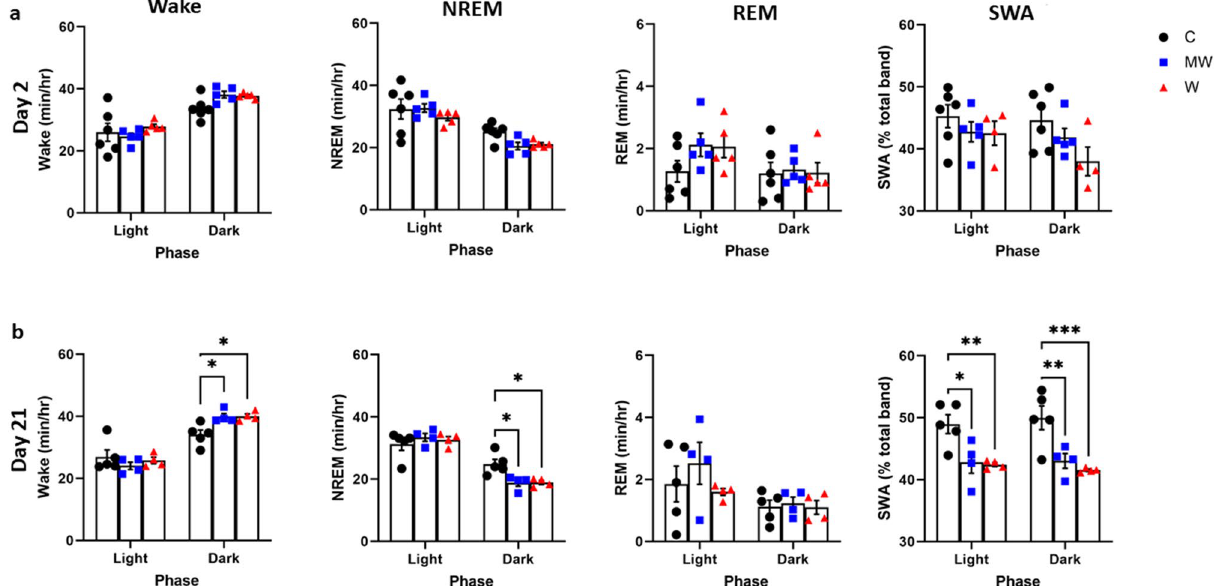
Figure 2. Sleep–wake stages during days 2 and 21 of the PCMS timeline per phase. There were no noticeable disparities in the amount of wake, rapid eye movement (REM) sleep, and slow-wave activity (SWA) during non-rapid eye movement (NREM) sleep on day 2 of predictable chronic mild stress (PCMS). The amount of NREM sleep tends to decrease during the dark phase ( a ). On day 21 of PCMS, increase in the amount of wake, while decrease in the amount of NREM sleep and SWA during NREM sleep were observed. A W group mouse containing artificial noise was excluded from SWA analysis on day 2 ( b ). N = 4–6 per group; * p < 0.05; ** p < 0.01; two-way ordinary ANOVA followed by Dunnett’s multiple comparison test. Data are presented as means ± F (46, 414) = 1.163, P = 0.224) of the PCMS timeline. Analogously, the LA during day 2 (Fig. 1e, F (46, 414) = 1.056, P = 0.379) and day 21 (Fig. 1e, F (46, 414) = 0.9231, P = 0.618) were not affected by the predictability of stress condi- tions in the MW and W groups compared with the C group. PCMS decreased the SWA during NREM sleep. On day 2 of PCMS, there were no changes in the amount of wake, REM sleep, and SWA during NREM sleep across the phases, while the amount of NREM sleep tended to decrease in MW and W groups (Fig. 2a). This observation was similar when the values across zeitgeber time (ZT) were compared (Supplemental Fig. S2a). The duration of episodes in the dark phase of NREM sleep decreased in MW ( P = 0.040) and W ( P = 0.011) groups (Supplemental Fig. S3a, F (2, 13) = 5.898, P = 0.015). On day 21 of PCMS, the MW ( P = 0.013) and W ( P = 0.012) groups compared to the C group manifested an overall increase in the amount of wake during the dark phase (Fig. 2b, F (2, 11) = 5.192, P = 0.026). In conjunction, the amount of NREM sleep of MW ( P = 0.008) and W ( P = 0.008) groups significantly decreased compared with that of C group in the same phase (Fig. 2b, F (2, 11) = 5.331, P = 0.024).The episode number of NREM sleep in the dark phase tended to decrease in the MW and W groups (Supplemental Fig. S3b, F (2, 10) = 4.621, P = 0.038). In contrast, on day 2, SWA during NREM sleep in the dark phase tended to decrease in W group (Fig. 2a) and the EEG power spectra in the SWA frequency band during NREM sleep also decreased in the dark phase in W group only (Supplemental Fig. S4a). Correspondingly, on day 21 of PCMS, both SWA (Fig. 2b) and EEG spectra (Supplemental Fig. S4a) during NREM sleep significantly decreased in both light and dark phases. There was no significant effect on EEG spectra during REM sleep (Supplemental Fig. S4b). Heightened mechanical pain sensation in the water group. Mechanical hyperalgesia was observed on day 2 (Fig. 3a, F (2, 19) = 4.590, P = 0.024) in the W group ( P = 0.015), and day 21 (Fig. 3a, F (2, 19) = 10.44, P < 0.001) on the same W group ( P < 0.001), subjected to the tail clip test. Faster reaction time to aversive thermal stimulus on PCMS. Increased sensitivity to aversive hot temperature was also observed amongst the PCMS groups in the tail immersion test on day 2 (Fig. 3b, F (2, 19) = 21.69, P < 0.001) and day 21 (F (2, 19) = 14.30, P < 0.001). All of the mice under the different PCMS condi- tions of MW ( P < 0.001) and W ( P < 0.001) experienced more pain induced by hot temperature on day 2 than the C group. On day 21, the MW ( P < 0.001) and W ( P < 0.001) compared to the C group had aggravated thermal pain as well. PCMS induced faster latency and more frequent reaction to the hot plate test.